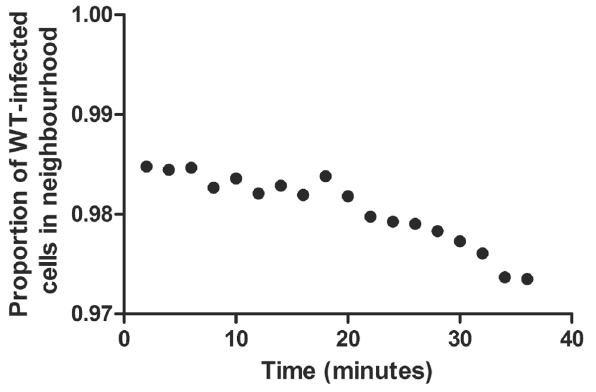
Figure 3. Existence of clusters of wild type and variant-infected cells. The percentage of wild type-infected cells neighbouring a wild type-infected cell is significantly higher than the percentage of variant- infected cells. The same is true for variant-infected cells. We track simulated wild type and variant-infected CD4 + T cells ( < 500 cells) for multiple timepoints. Abbreviations: WT/WT=Wild type infected cells in the immediate area (r=1, i.e. 26 nodes considered) surrounding a wild type-infected cell, WT/VAR=Wild type infected cells in the immediate area surrounding a variant-infected cell, WT/ALL=Wild type-infected cells on the whole grid. VAR/VAR, VAR/WT and VAR/ALL are defined similarly.